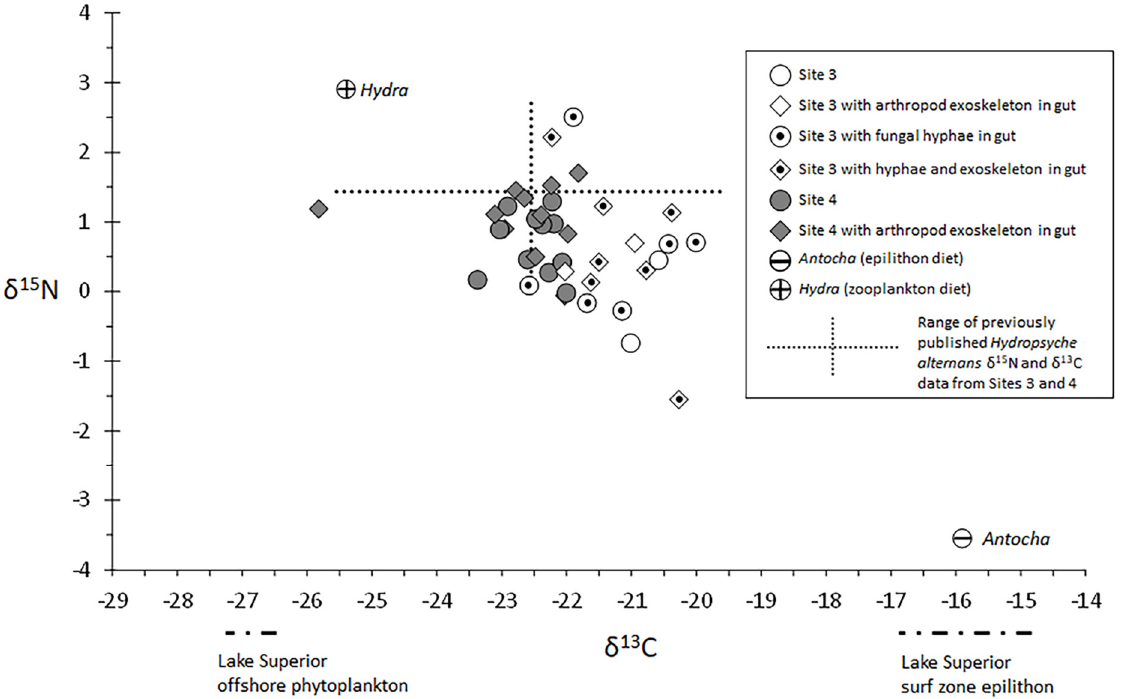
Figure 12. Stable isotope data for 4th and 5th instar Hydropsyche alternans from Sites 3 and 4. Positions of Hydra (Cnidaria, Hydrozoa, and Hydridae) and Antocha (Insecta, Diptera, and Limoniidae) are included to show the relative positions of a trophic level 3 planktivore ( Hydra ) within this food web, and a trophic level 2 benthivore ( Antocha ) that commonly occurs in close association with Great Lakes surf zone Hydropsychidae retreats (Barton and Hynes 1978) [1]. Increasing trophic level is indicated by increasing δ 15 N values. Within this range, more negative δ 13 C values indicate pelagic (planktonic) energy. Less negative δ 13 C values indicate benthic energy. Antocha, Hydra , and Hydropsyche alternans δ 15 N and δ 13 C data and δ 13 C data for Lake Superior surf zone epilithon are from [3]. Lake Superior offshore phytoplankton δ 13 C data are from [65].